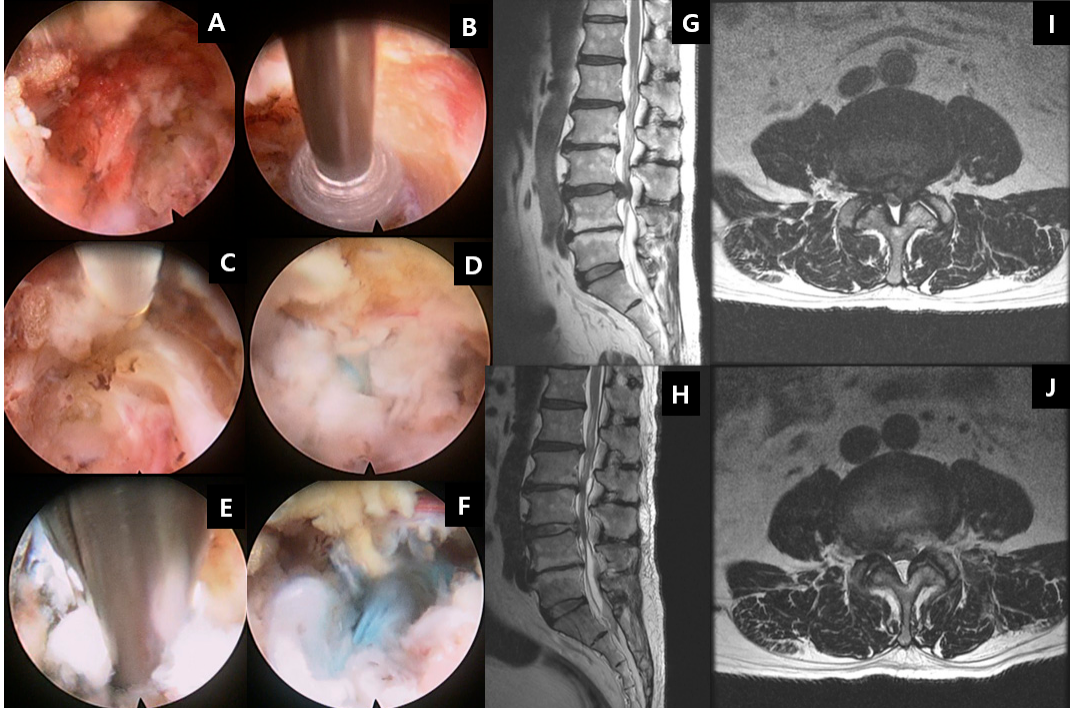
Figure 5. Transforaminal endoscopic lumbar discectomy (TELD). Using a beveled-type working cannula with an 8 mm outer diameter. The endoscope is introduced into the surgical field, with the entire procedure performed using constant saline irrigation. A shows the exiting nerve root in view with its surrounding epidural fat tissue. B shows the drilling of the superior articular facet under direct endoscopic vision. C shows the dissection of the foraminal ligament. D showes the exposure of the disc after manipulation of the working channel and endoscope to bring the disc in view. E shows the removal of the disc with endoscopic forceps. F shows the decompressed disc underneath floating neural elements. The blue stain on the disc was caused by indigo carmine disc injection, which served as a colored marker for ease of identification of disc herniation. G shows the herniation of the left L3 / 4 disc compressing on the neural element in sagittal MRI, which was removed and demonstrated in post-operative MRI of the same level sagittal cut in H . I shows the herniation of the left L3 / 4 disc compressing on the neural element in the central, paracentral, and foraminal region axial MRI, which was removed and demonstrated in post-operative axial MRI of the same level axial cut in J